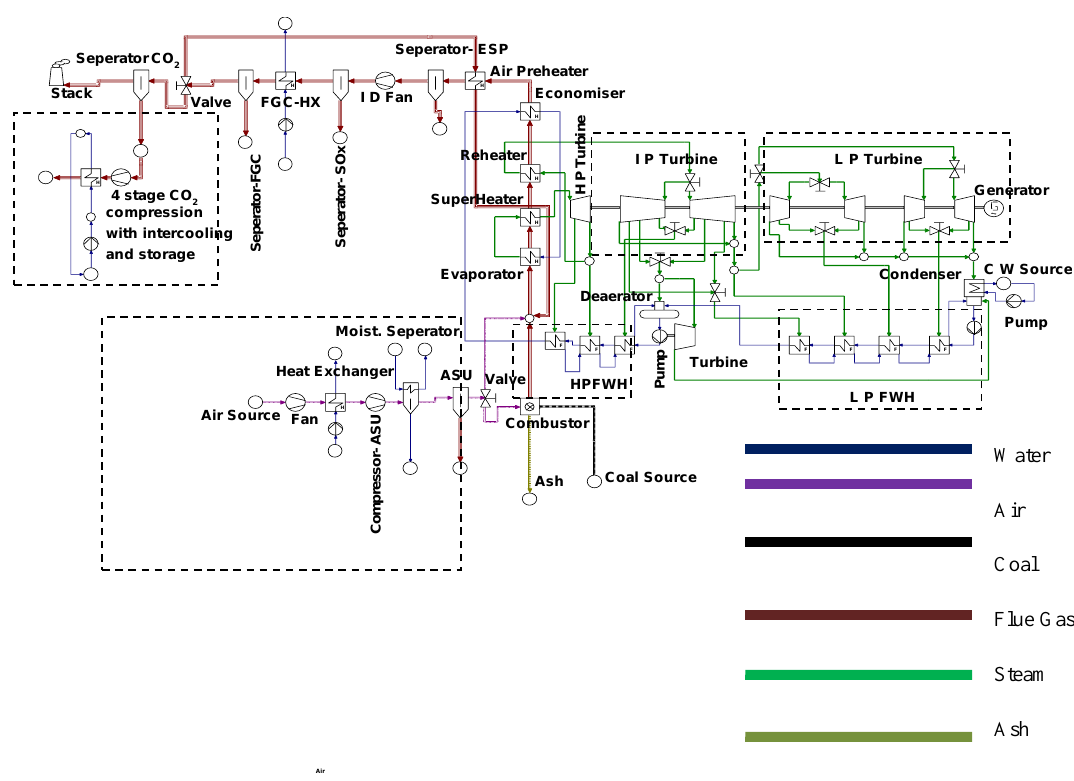
Figure 2. Schematic diagram of an OCC based 500 MW e SupC power plant with CO 2